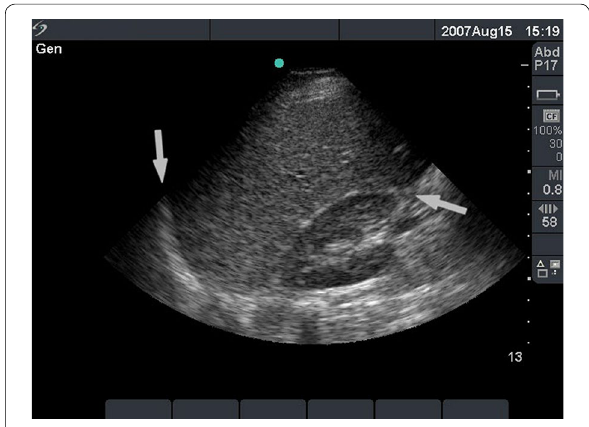
Fig. 7 Normal hepatorenal recess. A normal ultrasound image of the hepatorenal recess (Morison’s pouch). A phased‑array cardiac transducer was used with the abdominal settings. The left arrow indicates the diaphragm. The right arrow indicates the hepatorenal recess. The liver is shown above this line and the right kidney below